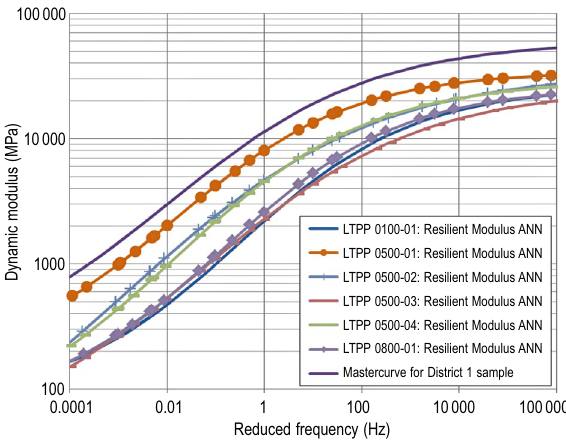
Fig. 2. Dynamic modulus mastercurves from laboratory tests and LTPP resilient modulus ANN model